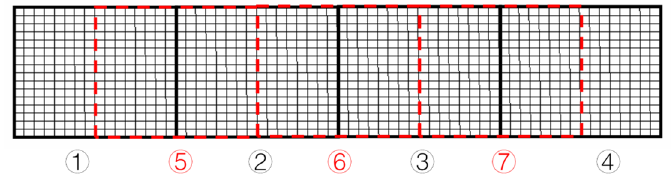
Figure 4. Sub-images in task decomposition: ① – ⑦ represents seven sub-images.